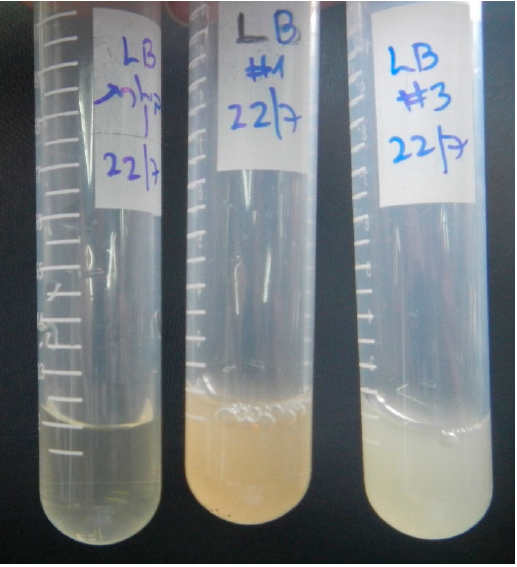
Figure 5. LB overnight starters. Left : control (no bacteria), Center : Rhodococcus rhodochrous , Right : Ochrobactrum anthropi .